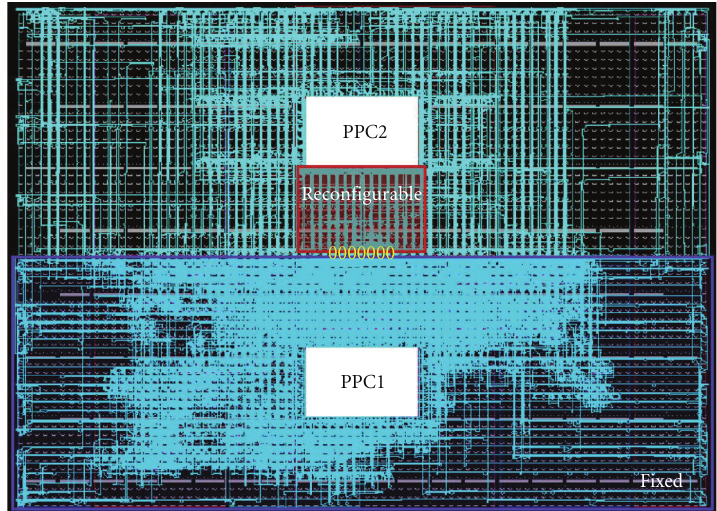
Figure 3: Layout of our sample system: the small highlighted area is